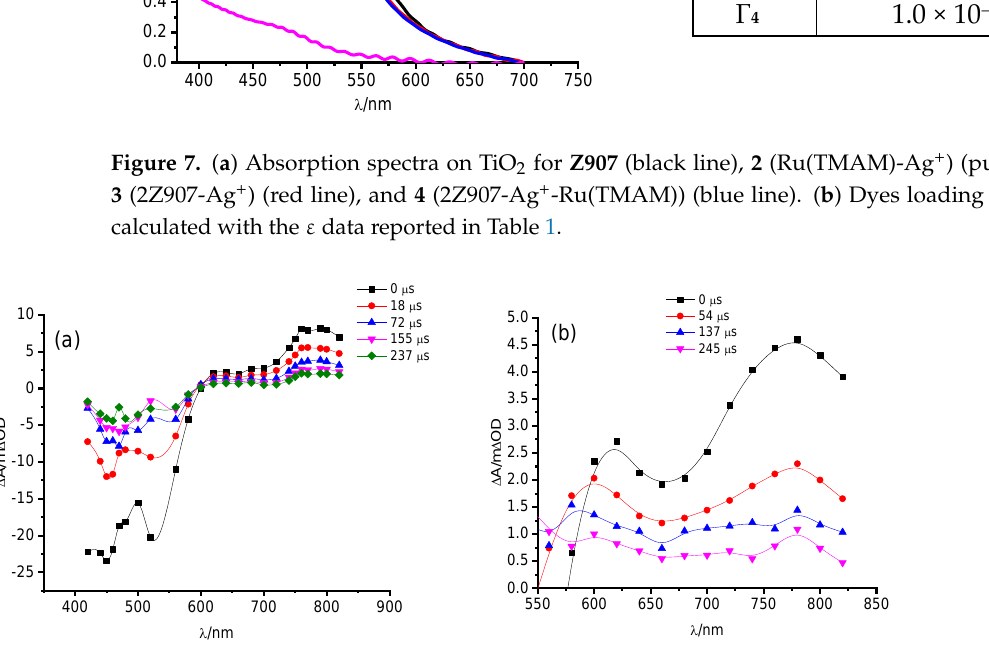
Figure 8. TAS recorded on TiO 2 for ( a ) 3 (2Z907-Ag + ) and for ( b ) 4 (2Z907-Ag + -Ru(TMAM)). Thin films are in contact with 0.1 M Li + in